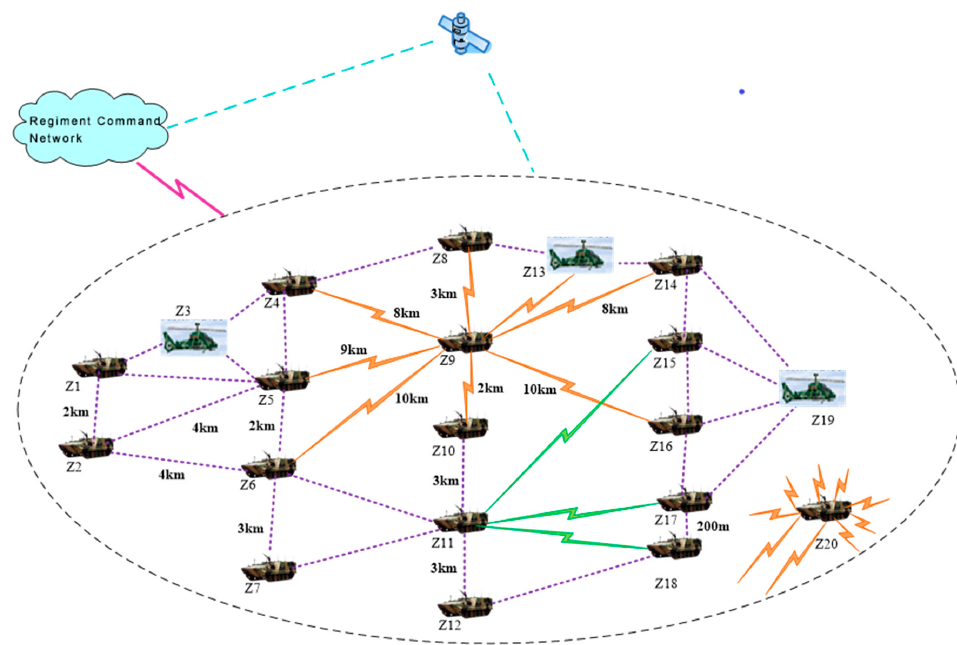
Figure 2. Awareness combat network with planar peer-to-peer structure.